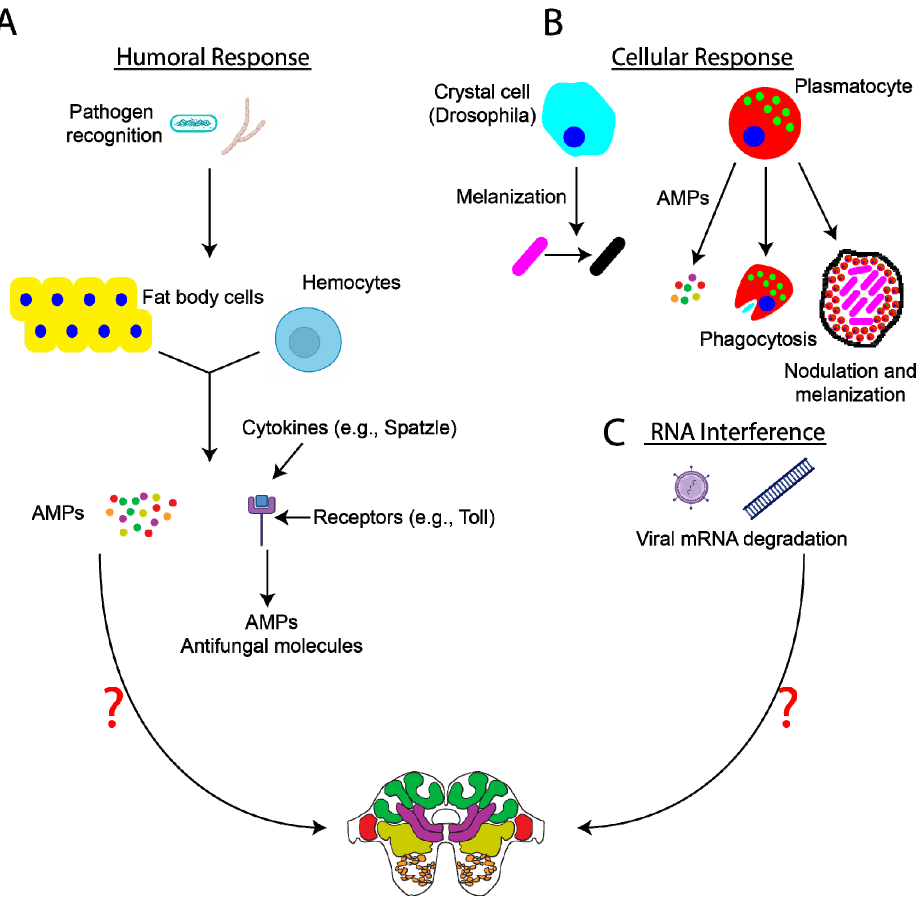
Figure 1. Insect immune responses and potential impacts on the nervous system. Insects utilize many different methods to fight off infection, which are reviewed here [37,40]. Briefly, ( A ) the humoral immune response involves the release of antimicrobial peptides (AMPs) from fat body cells and hemocytes into the hemolymph. AMPs aid in the targeting and destruction of different pathogens (e.g., bacteria and fungi). Intracellular signaling events (e.g., Spätzle/Toll, immune de- ficiency (IMD), and JAK–STAT signaling) are activated, leading to the synthesis of AMPs and the induction of different immune responses. Recent data have indicated the presence of immune priming in insects, making the insect immune system more adept at fighting off repeat infections than previously believed [43,46]. ( B ) Cellular responses to infection include, but are not limited to, the induction of processes such as melanization and nodulation, which effectively isolate and neutralize pathogens, and pathogen phagocytosis. Lastly, RNA interference ( C ) can mediate the degradation of viral genetic material. At present, it remains relatively unclear specifically how these processes (e.g., release of AMPs, altera- tions in intracellular signaling, phagocytosis, etc.) impact neural and glial cell function and host behavior (as indicated by the question marks). Images created with BioRender.com (accessed January 15, 2021). 3. Host Behavioral Change Associated with Microbial Infection There are many different viruses, bacteria, and fungi that induce changes in the be- havior of the hosts that they infect. These behavioral changes are often stereotypical, and, in many cases, the manifestation of these behavioral changes is hypothesized to aid in the